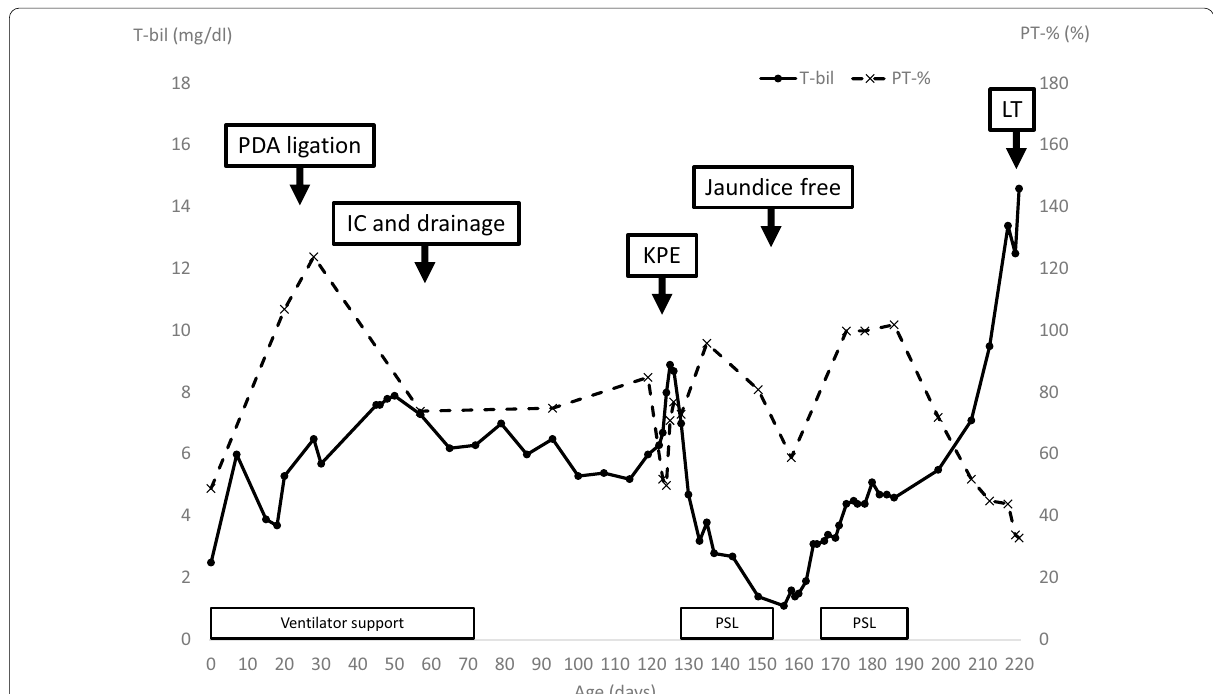
Fig. 5 The trends in total bilirubin and PT-%. PDA patent ductus arteriosus, IC intraoperative cholangiography, KPE Kasai portoenterostomy, LT liver transplantation, PSL